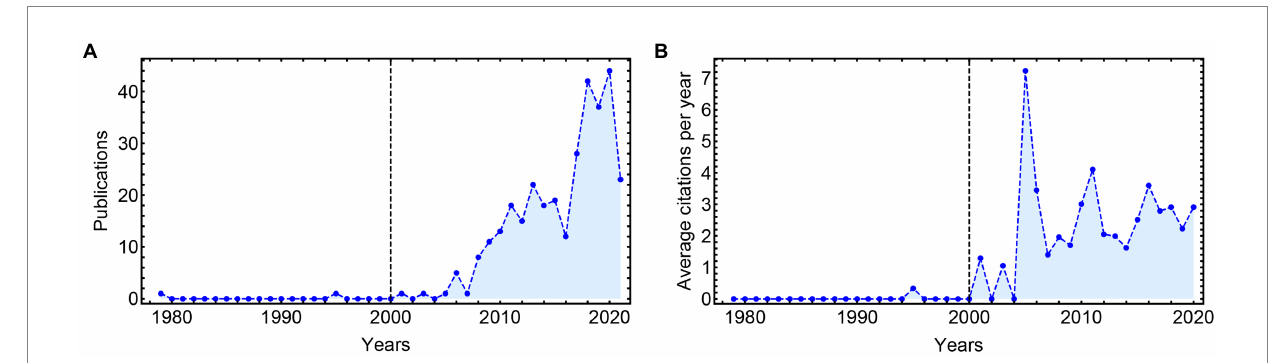
FIGURE 2 Time evolution of the GCE literature (A) and its corresponding average citations evolution (B) in the period 1979–2021. The dashed line displays a phase transition of two main production’s